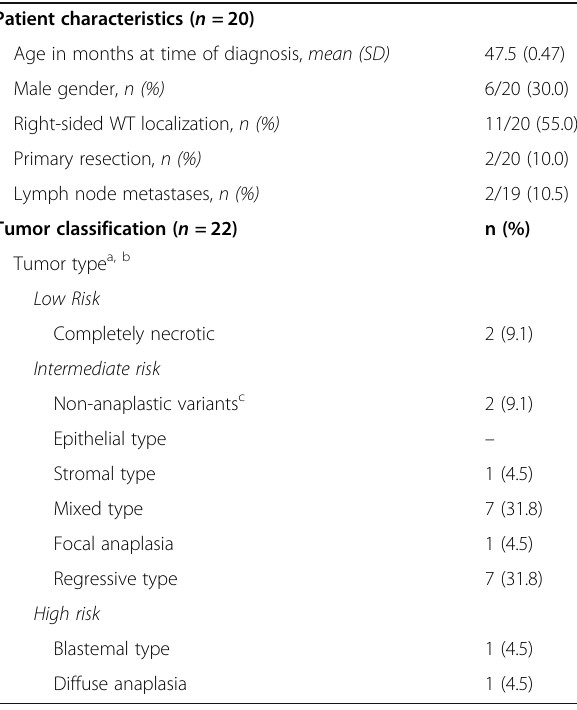
Table 2 Patient characteristics and tumor classification Patient characteristics ( n =